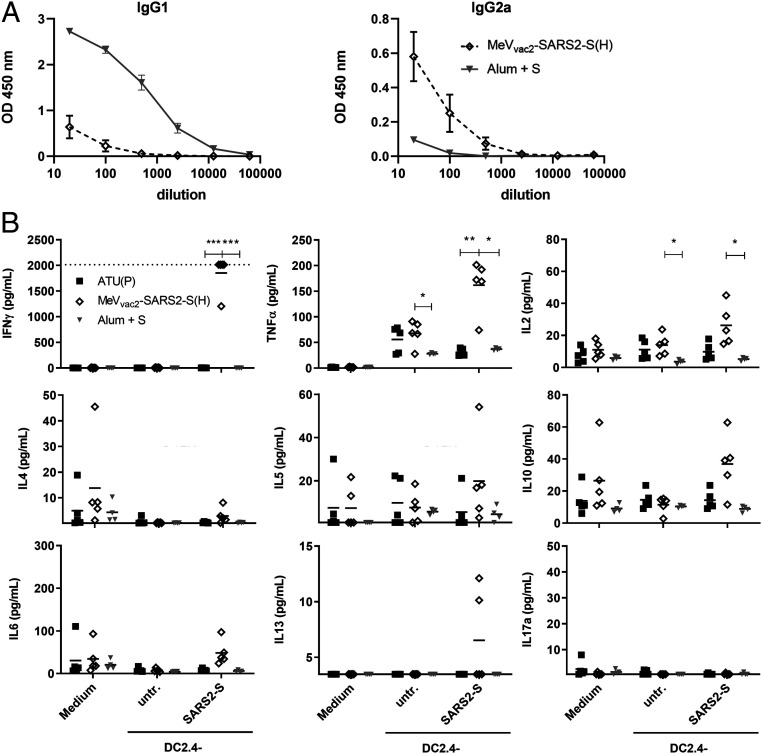
Immune bias of induced responses. To analyze skewing of immune responses toward Th1- or Th2-biased immunity, (A) sera and (B) splenocytes of vaccinated mice depicted before were analyzed. (A) Sera of mice vaccinated on days 0 and 28 with MeVvac2-SARS2-S(H) or Alum-adjuvanted S protein already shown in Fig. 2 were analyzed for IgG1-or IgG2a-type antibodies specific for SARS-CoV-2 S. IgG1 (Left) or IgG2a (Right) binding to recombinant SARS-CoV S were determined by ELISA via the specific optical density (OD) 450-nm value. Depicted are means and respective SD of the mean (SEM) of each group (n = 6 to 7). (B) Splenocytes of the same mice already shown in Figs. 3–5 and SI Appendix, Fig. S8 were analyzed by multiplex cytokine analysis for secretion of typical marker cytokines in the supernatant after restimulation by coculture with antigen-presenting DC2.4-SARS2-S cells. DC2.4 cells served as nonspecific control stimulus. Dots represent individual animals; horizontal bars are mean per group (n = 4 to 5). IFN-γ: upper limit of detection (ULOD): 2,015.2 pg/mL; IL-6: ULOD: 3,992.4 pg/mL; IL-17a lower limit of detection (LLOD): 0.473 pg/mL; IL-4 LLOD: 0.095 pg/mL; IL-5 LLOD: 0.685 pg/mL; IL-13 LLOD: 3.463 pg/mL. For statistical analysis of grouped multiplex data, two-way ANOVA analysis was applied with paired Tukey’s multicomparison test as post hoc test. *P < 0.05; **P < 0.01; ***P < 0.001.